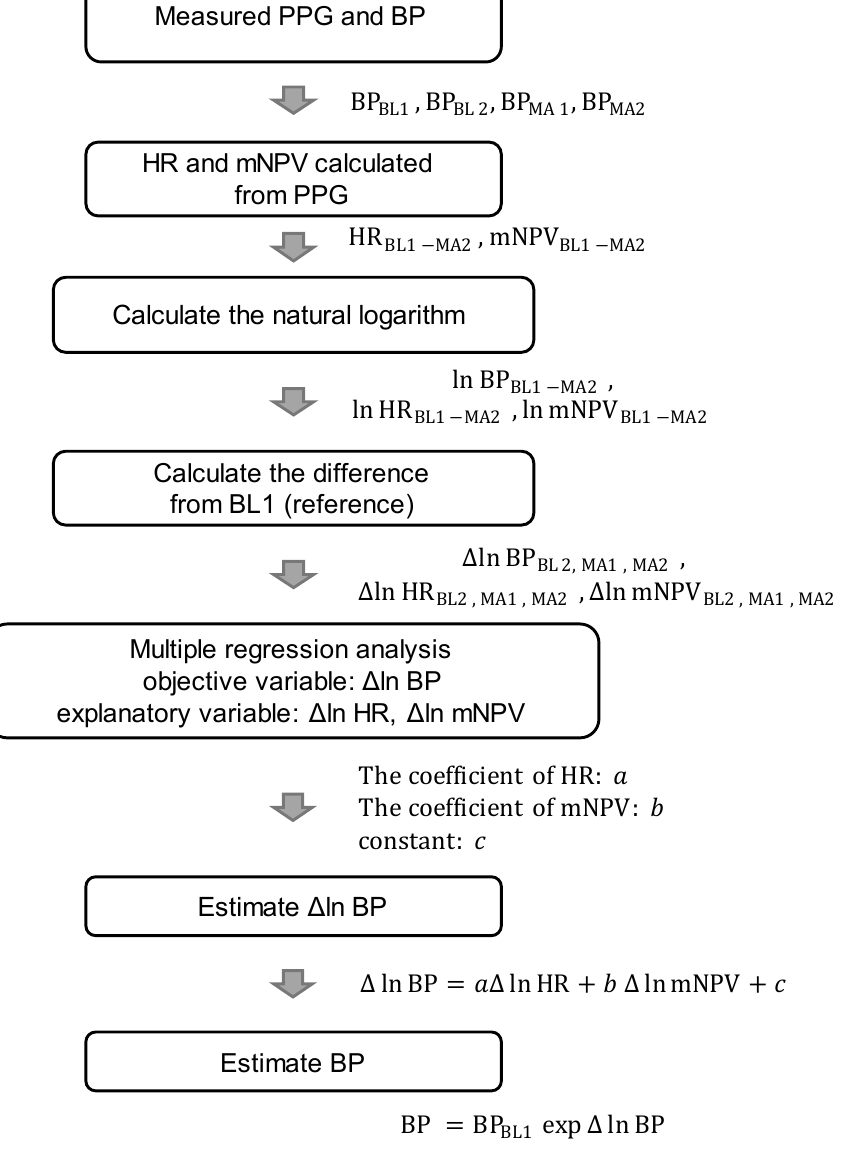
Figure 5. Flowchart of BP estimation. BP = blood pressure (SBP/DBP/MAP), HR = heart rate, and mNPV = modified normalized pulse volume.